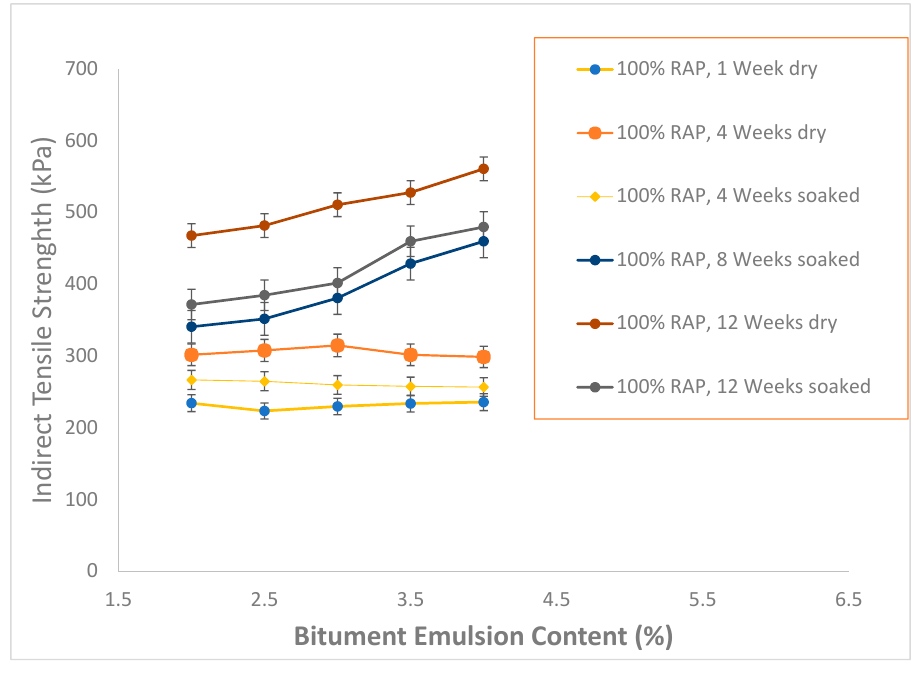
Figure 9. Indirect tensile strength of different asphalt mixes.